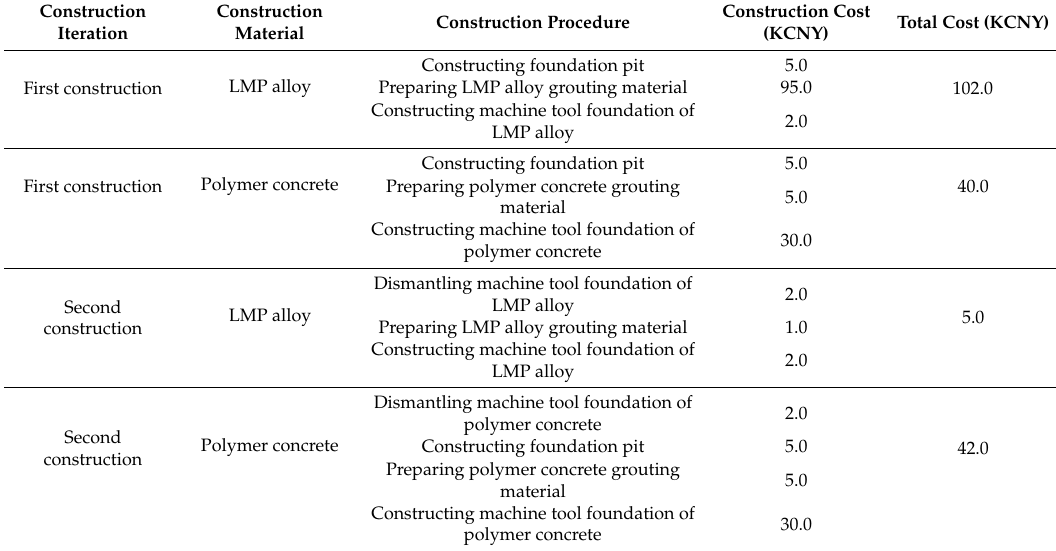
Table 6. Machine tool foundation construction